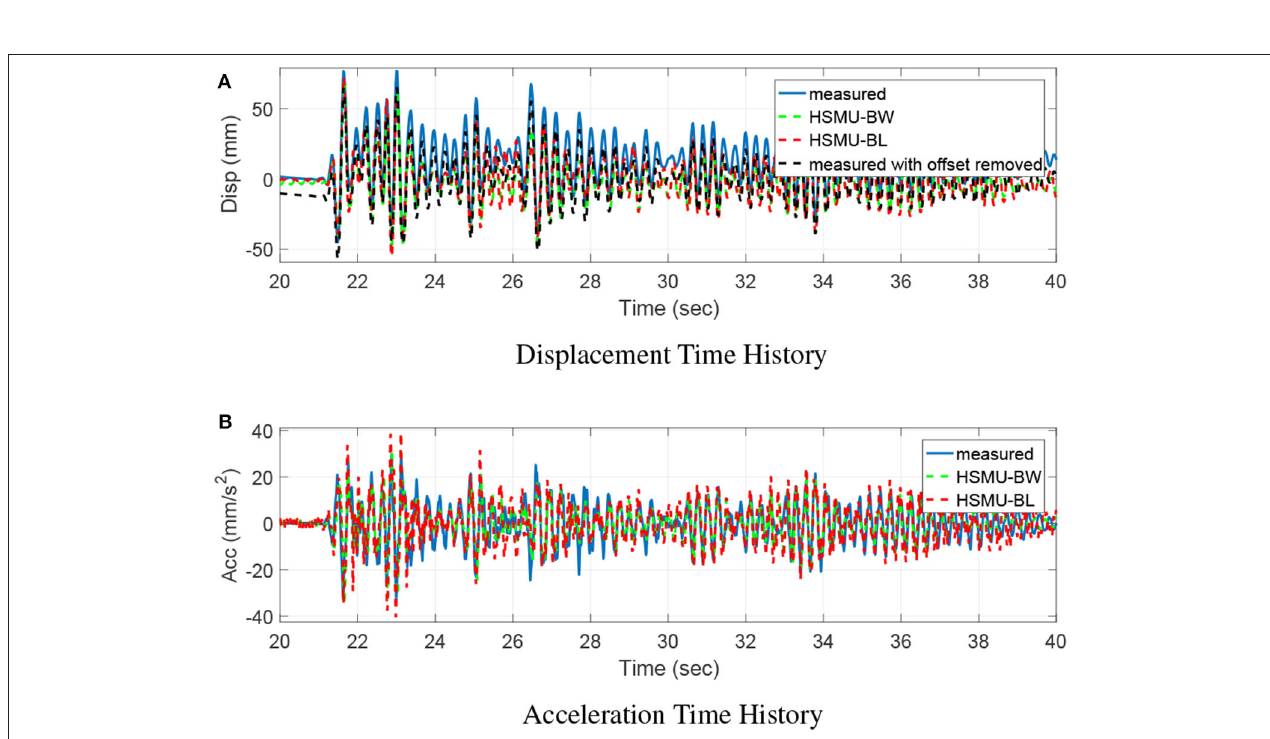
FIGURE 8 | S2: Top floor time history responses. (A) Displacement time history, (B) Acceleration time history.